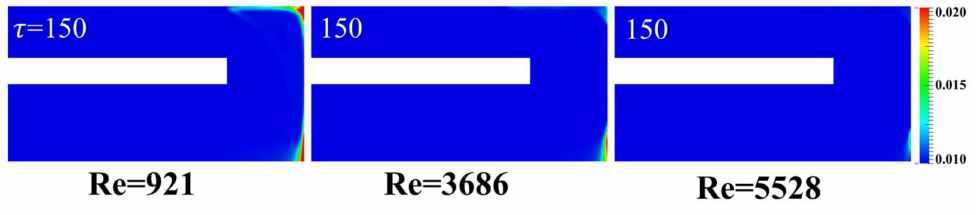
Figure 9. Nanoparticle concentration field at τ = 150 for different Reynolds numbers (Re).